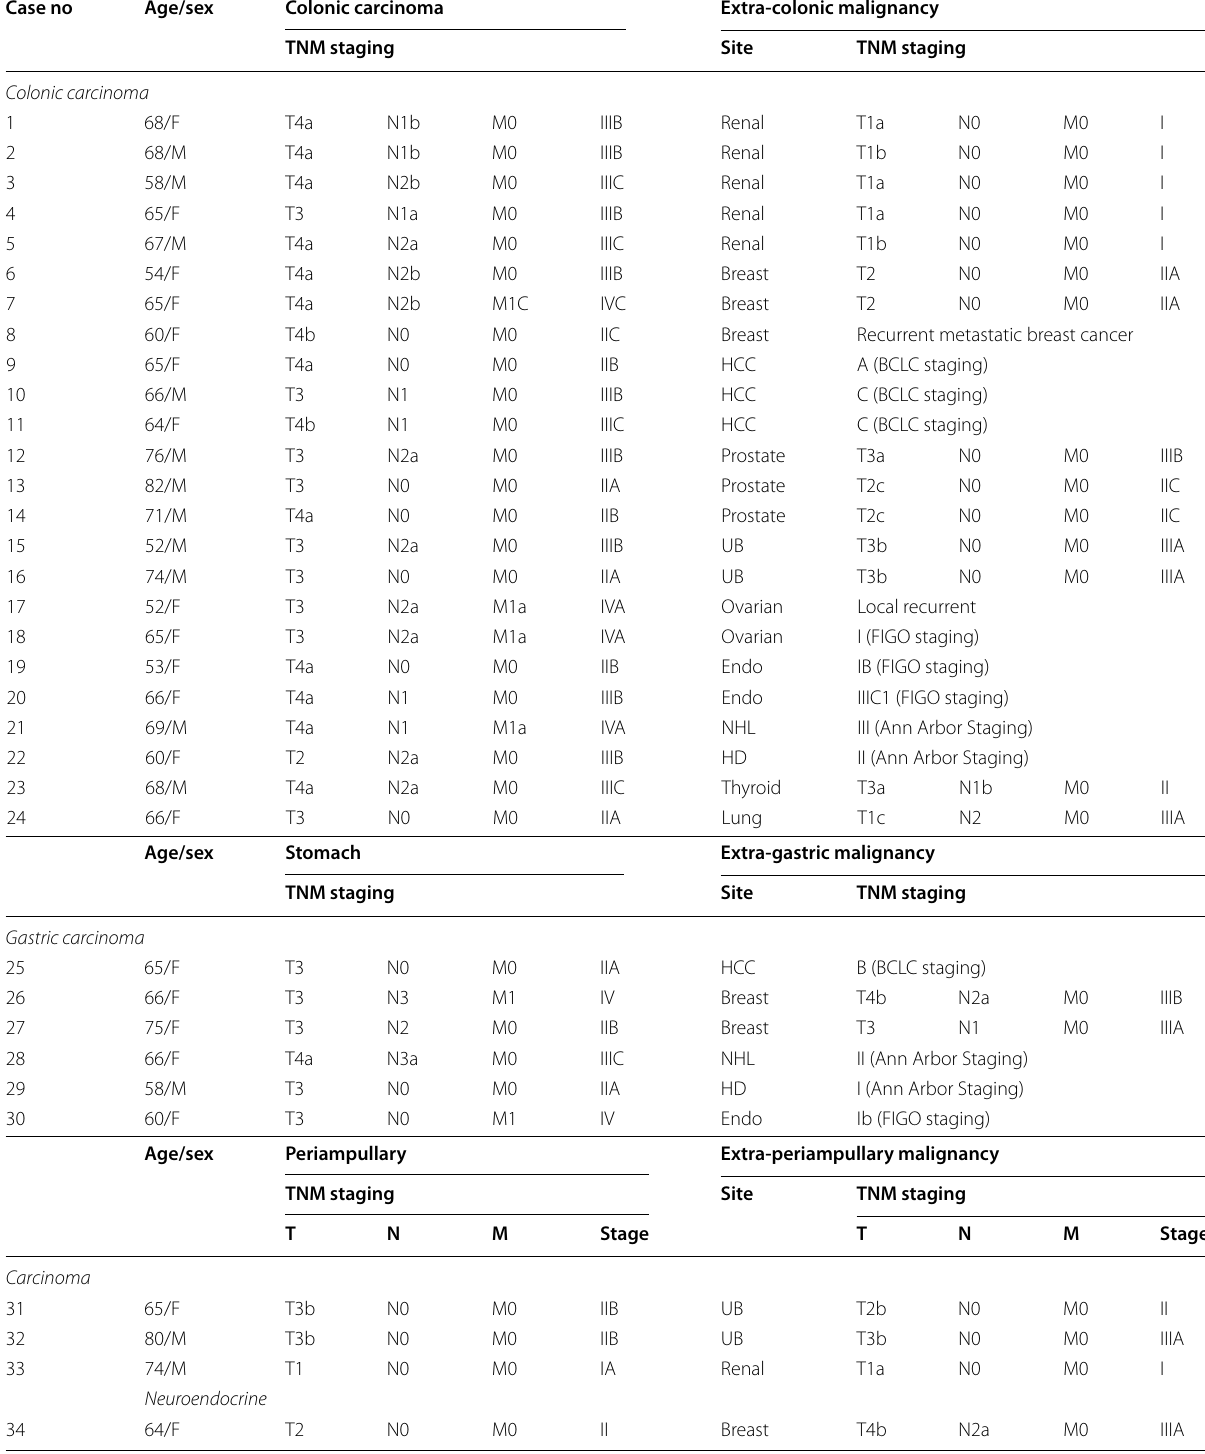
BCLC: Barcelona Clinic Liver Cancer staging classification, Endo.: Endometrial carcinoma, FIGO: the International Federation of Gynecology and Obstetrics, HCC: hepatocellular carcinoma, HD: Hodgkin disease, NHL: Non‑Hodgkin lymphoma, RCC: renal cell carcinoma, UB: urinary